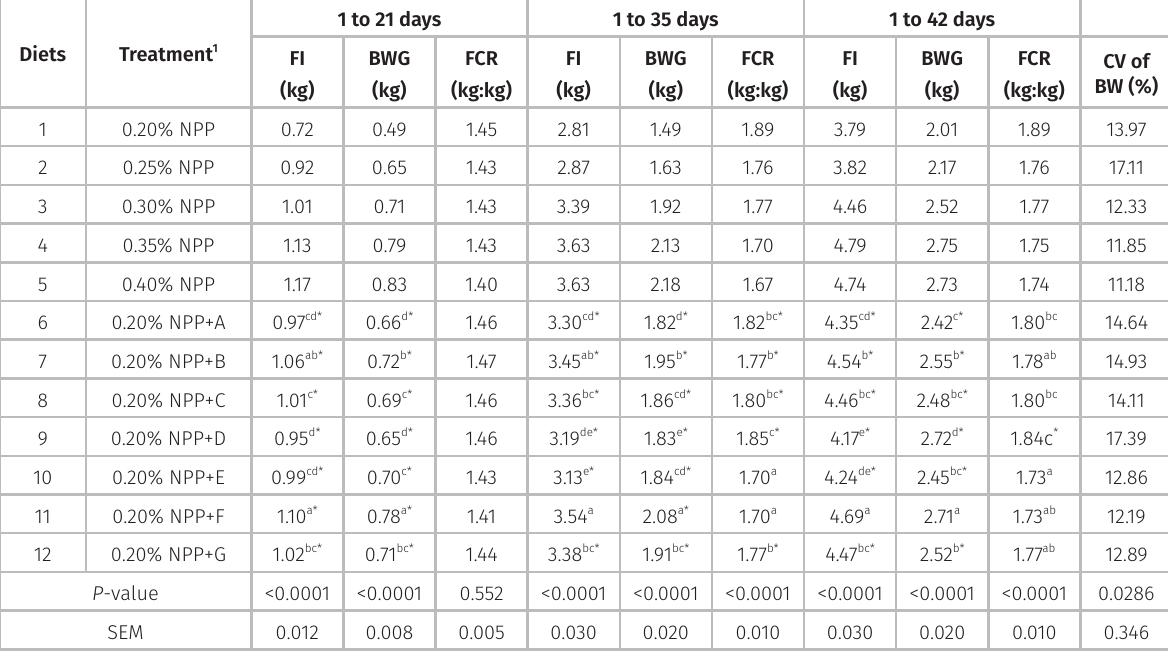
Table II. Summarized results for body weight (BW), feed intake (FI), body weight gain (BWG), feed conversion ratio (FCR) of broilers in the age periods from 1 to 21, 1 to 35, and 1 to 42 days.